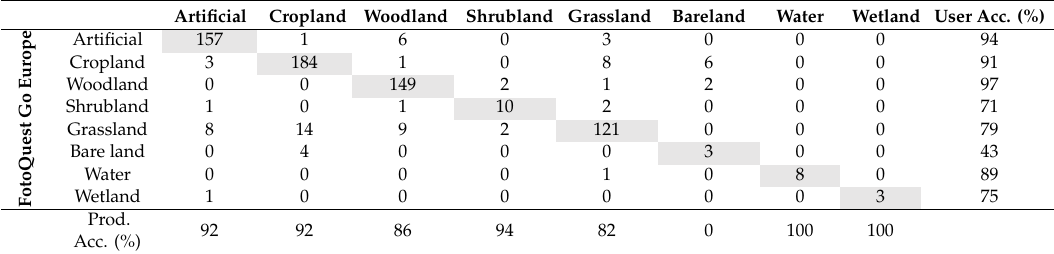
Table 5. Confusion matrix showing level 1 LC classifications from FotoQuest Go Europe and LUCAS 2018.